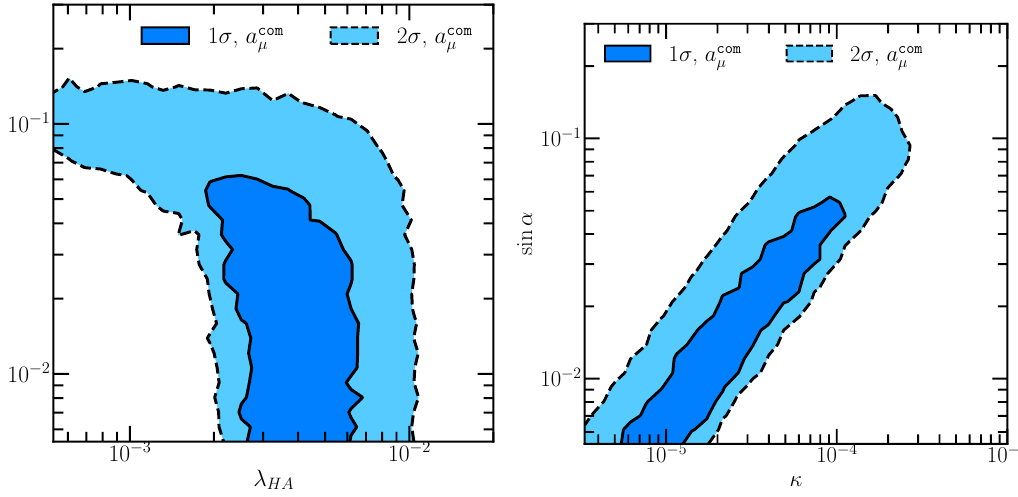
Figure 3 . The likelihood distribution in the ( λ HA , sin α ) plane (left) and the ( κ , sin α ) plane (right). Colors and constraints are as described in figure